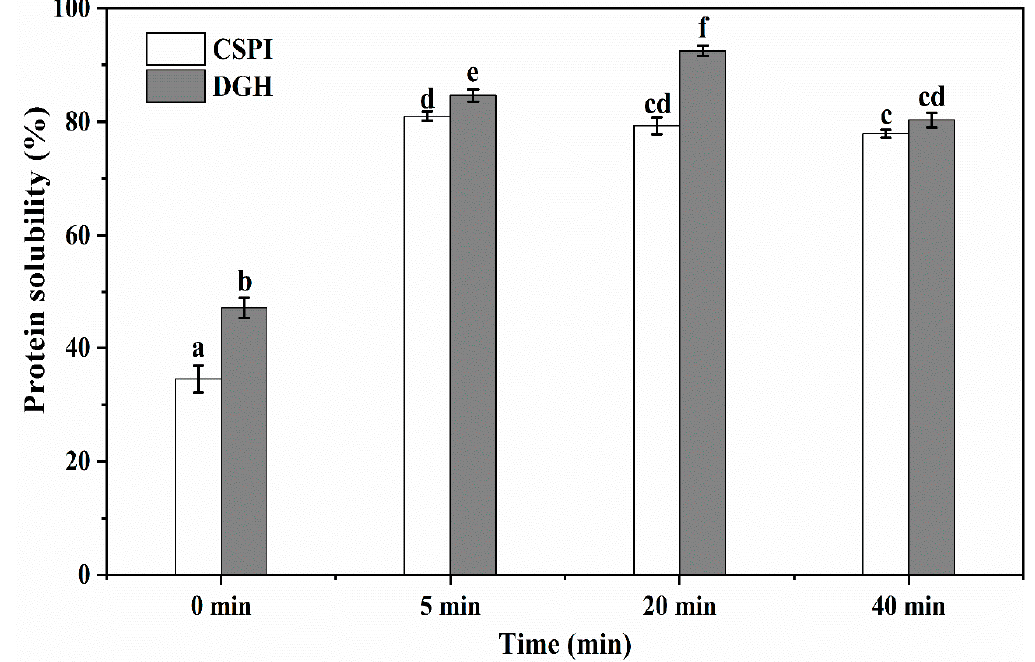
Figure 2. Effect of high-intensity ultrasound treatment (20 kHz at 400 W for 0, 5, 20, 40 min) on the protein solubility of CSPI and DGH. Different lowercase letters (a, b, c…) indicate significant differences between samples, at p < 0.05 using Duncan’s test. Error bars represent the standard deviations.